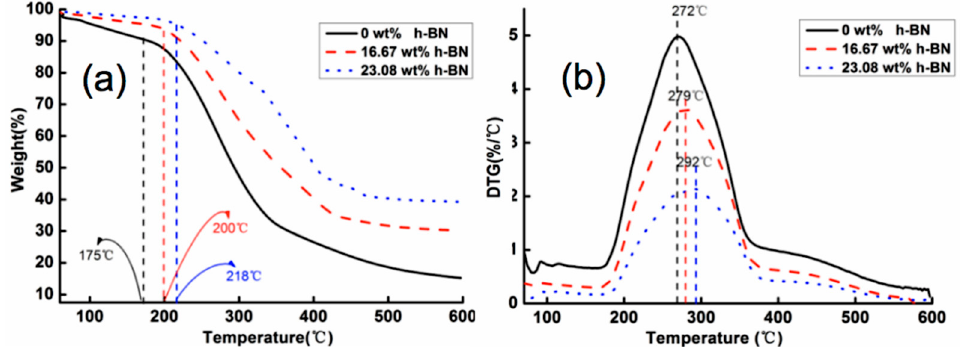
Figure 5. ( a ) Thermogravimetric (TG) and ( b ) Derivative thermogravimetry (DTG) curves of h-BN/CNF aerogel perfusion composite